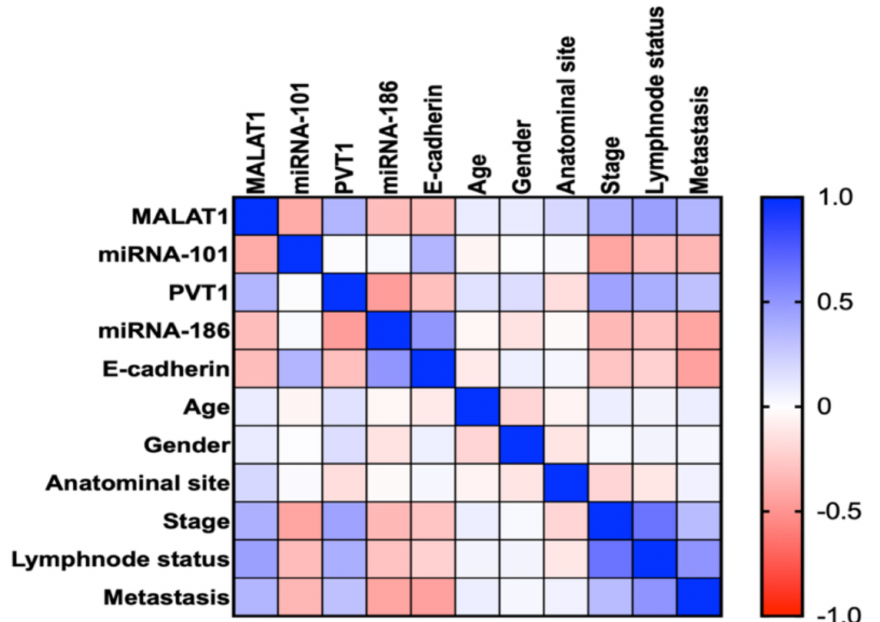
Figure 6. Correlations between studied serum markers with each other and with clinical data in CRC group. A correlation map with a blue-red (cold-hot) scale. The blue color corresponds to a correlation close to 1 and the red color corresponds to a correlation close to − 1. White corresponds to a correlation close to 0. Correlations are made by spearman